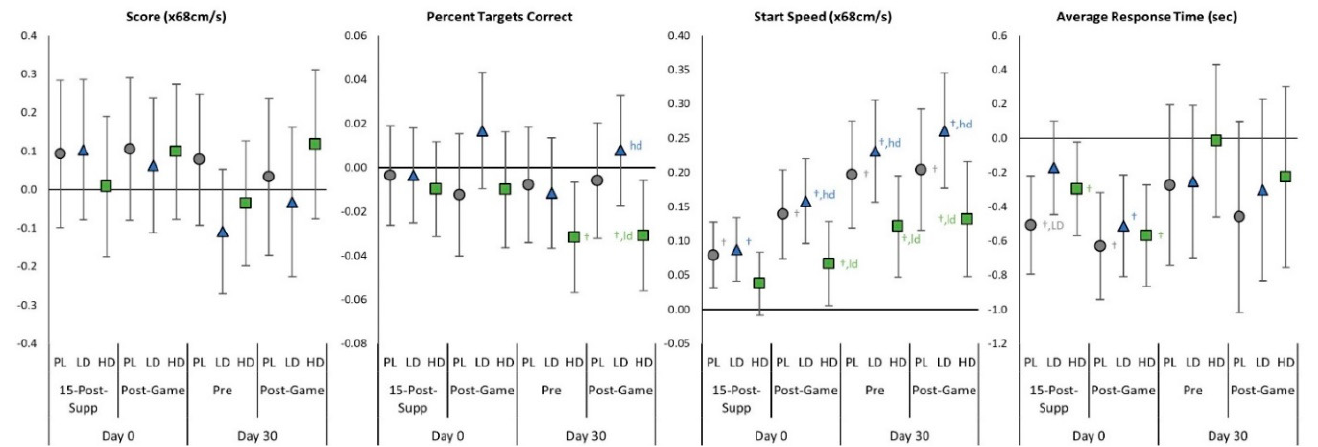
Figure 8. Light reaction test changes with 95% confidence intervals from Day 0, pre-game (Pre) values for the placebo (PL), low-dose (LD), and high-dose (HD) groups. † represents p < 0.05 from Pre values while ‡ represents p > 0.05 to p < 0.10 effect. 15-min-Post-Supp represents data obtained 15-min after supplementation and Post-Game represents data obtained after competitively playing video games for 60 min. Group differences ( p < 0.05) are shown as differences from placebo (pl), low-dose (ld), and high-dose (hd) groups, while statistical tendencies ( p > 0.05 to p < 0.10) are shown in large cases (PL, LD, HD).